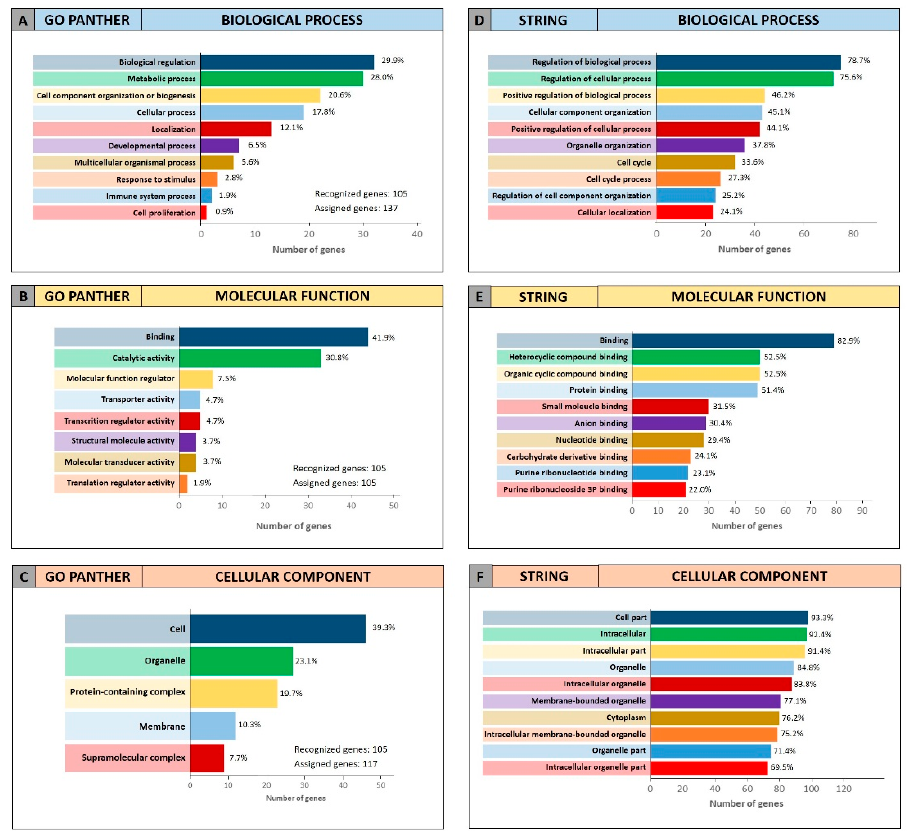
Figure 3. Gene Ontology enrichment of the 105 genes identified through miRCancerdb. Panel ( A , D ) GO PANTHER and STRING analyses of the “biological process” category; panel ( B , E ) GO PANTHER and STRING analyses of the “molecular function” category; panel ( C , F ) GO PANTHER and STRING analyses of the “cellular component” category.